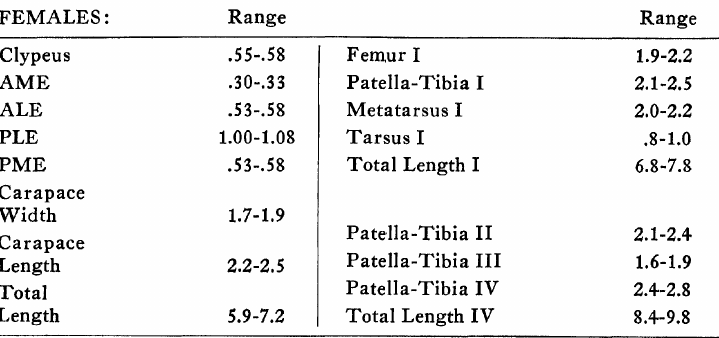
Figs. 78-79. Oxyopes bifidus F.O.P.-Cambridge, male from Compostela, Nayarit, 12 July 1972. 78. Left palpus, retrolateral view. 79. Left palpus, ventral view. Figs. 80-81. Oxyopes bifidus F.O.P.-Cambridge, male holotype from Acapulco, Guerrero. 80. Retrolateral view. 81. Ventral view. Figs. 82-83. Oxyopes cornutus F.O.P.-Cambridge, male holotype from Tierra Colorado., Guerrero. 82. Retrolateral view. 83. Ventral view. Scale on the left is for Figs. 78-79. Scale on the right is for Figs.